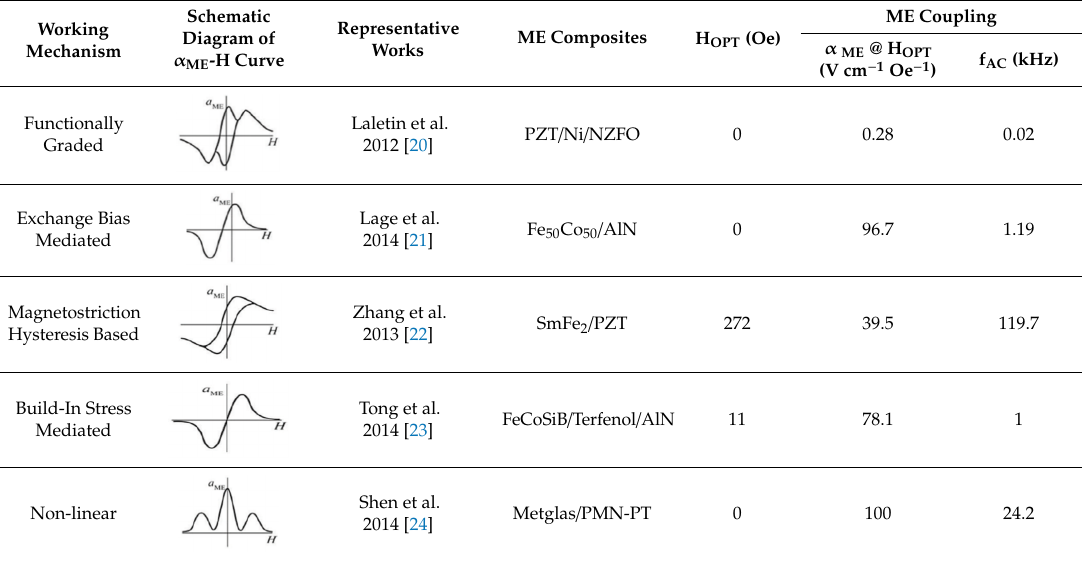
Table 1. The comparison table for representative works of self-biased magnetoelectric/multiferroic (SME) composites. [ α ME -H curve: the curve of ME coupling coefficient at different DC magnetic bias;